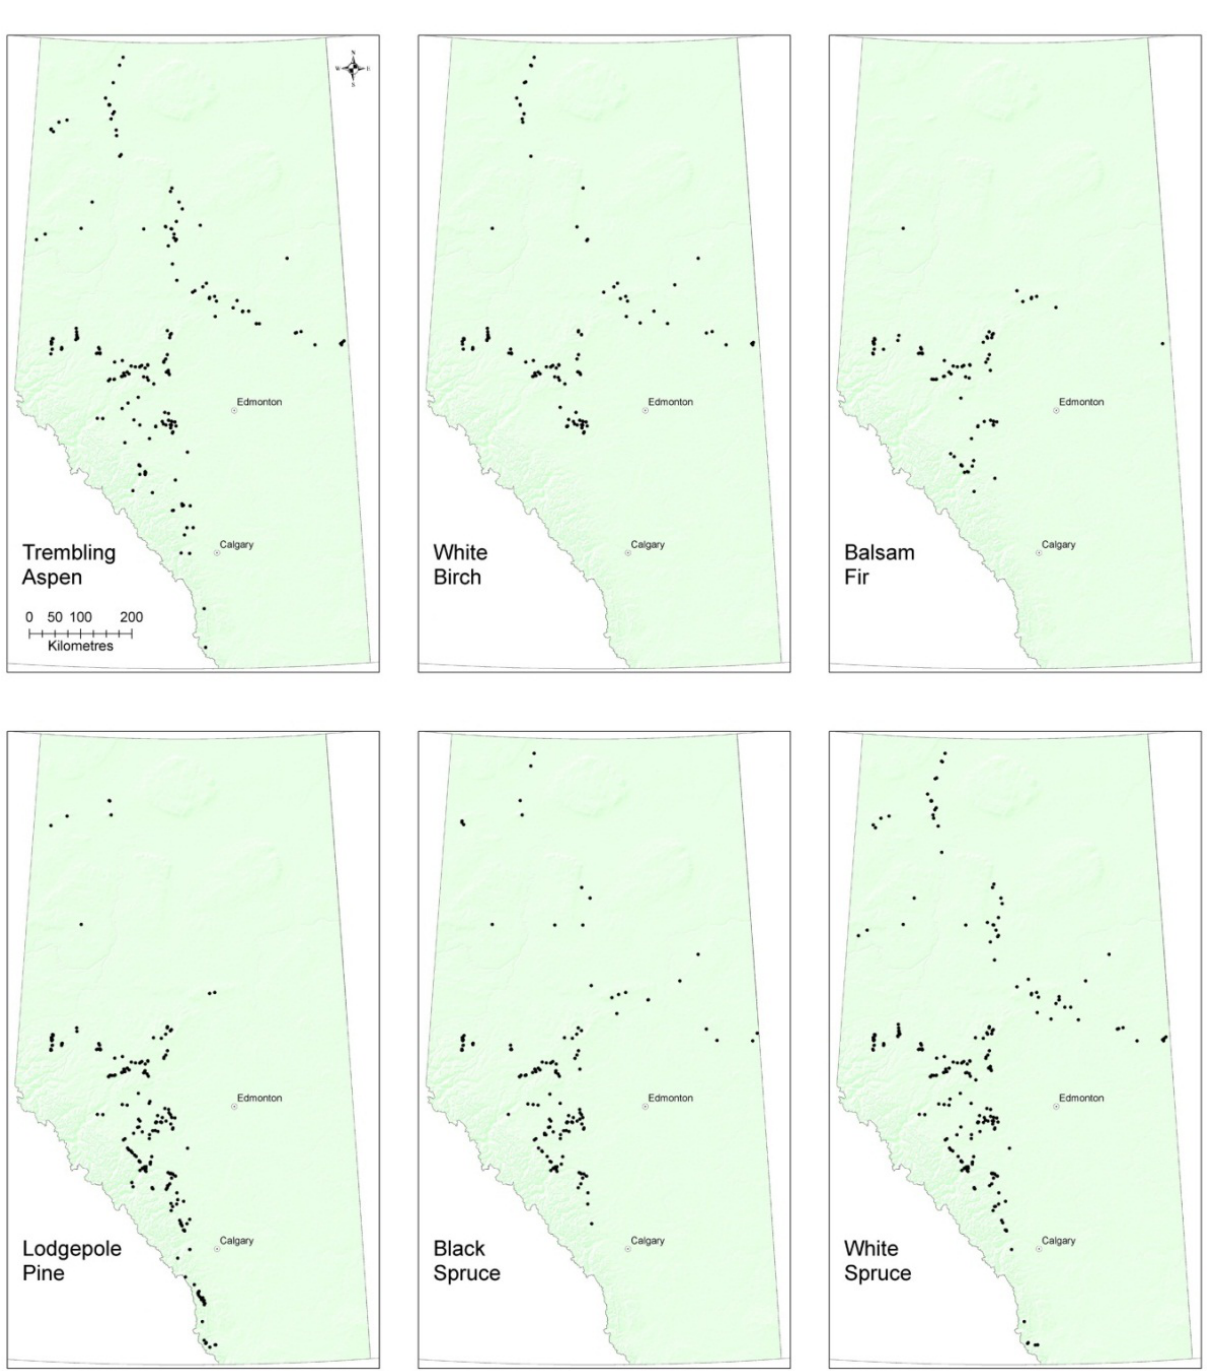
Figure 1. Location of individual Permanent Sample Plot (PSP) containing the various species. Note: each map shows the location of plots containing the labelled